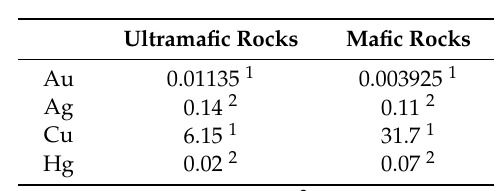
Table 1. Average contents of gold (Au), silver (Ag), copper (Cu), and mercury (Hg) (ppm) in the massif of ultramafic rocks (Southern Urals,